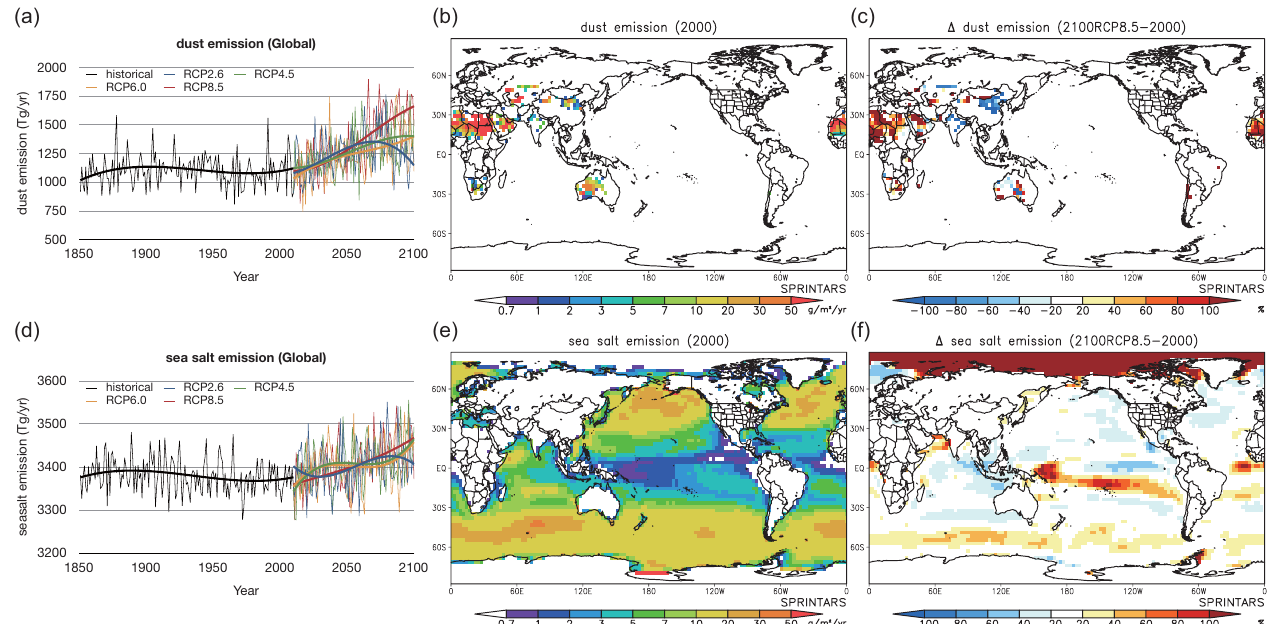
Fig. 5. Time series of annual and global total emissions of (a) soil dust and (d) sea salt, and global distributions of emissions of (b) soil dust and (e) sea salt in 2000 (averaged over the period 1998–2002) and their ratio in 2100 (averaged over the period 2096–2100) for the RCP8.5 experiment against 2000 of (c) soil dust and (f) sea salt simulated by SPRINTARS. In (a) and (d) , historical period is shown in black, the four RCPs are shown in colours, and the thick lines are regression